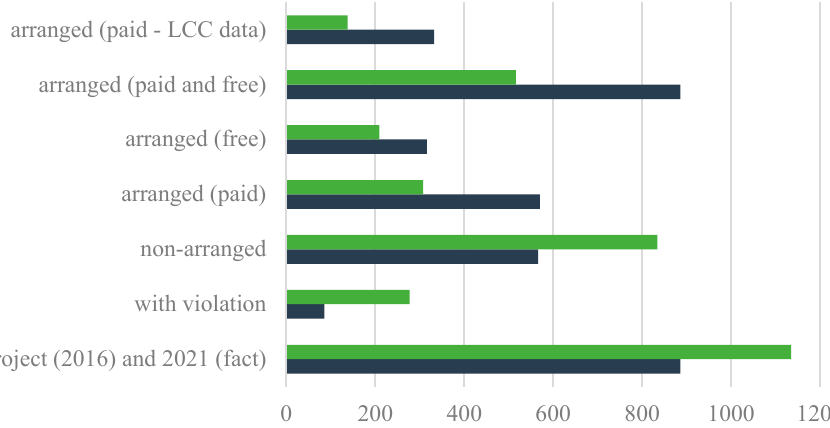
Figure 8. Comparative analysis of changes in on-street parking conditions, based on Tables 2 and 3 (2016—green and 2021—black).